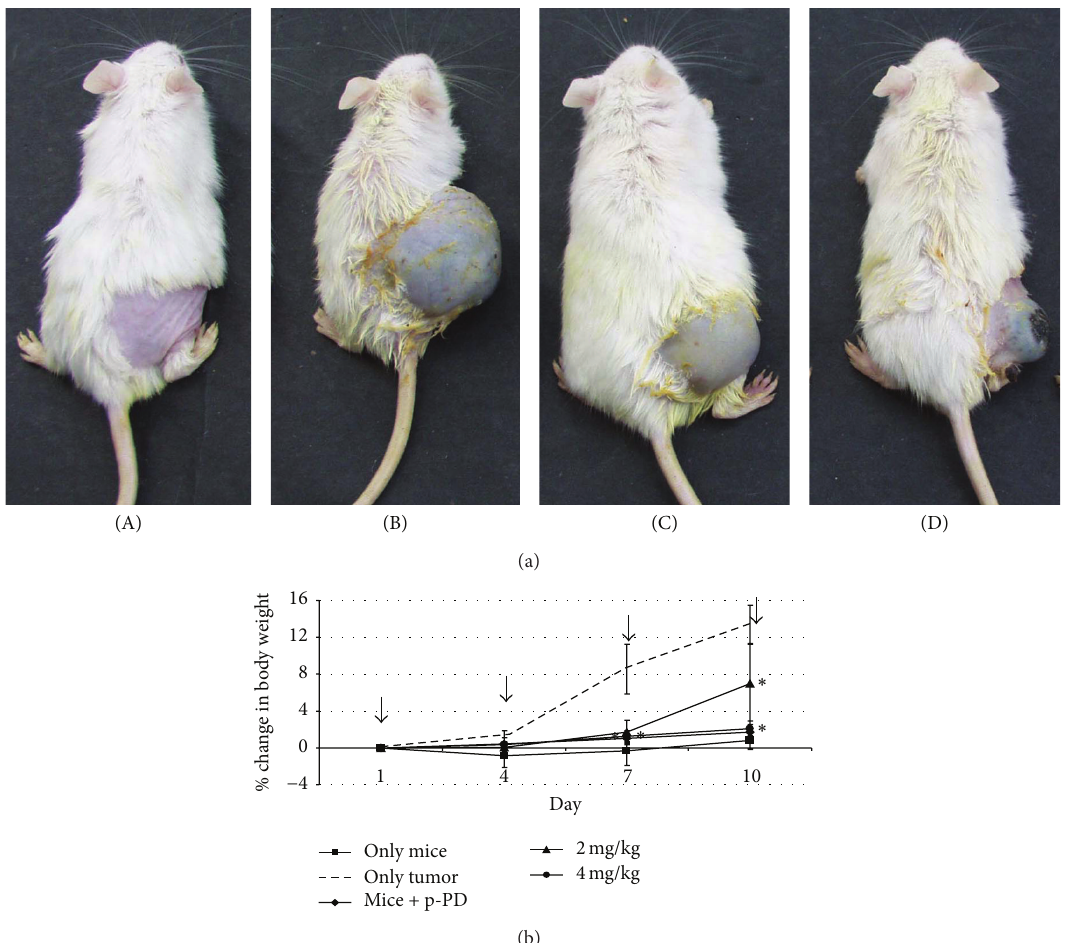
Figure 2: Body weight gain of the mice treated with or without p-PD. (a) Effect of p-PD on tumour development in mice. Initially, right flanks of two sets of Swiss-Albino mice were given subcutaneous injection with only PBS (A) and B16-F10 cells (B) as mentioned in the Materials and Methods. These mice were kept for 2 weeks until visible tumour in the set (B) is formed. The mice from set (B) were divided into three groups: one (C) was treated with 2 and the other (D) was treated with 4mg/kg of p-PD for 10 days. One (B) set was left untreated as control. Photographs of representative mouse from each set are shown here. Each set comprised 6 mice except for set (B) where initially 18 mice were used for the experiment. (b) Body weights of untreated mice (set (A) above) ( ◼ ), mice treated with 4 mg/kg of p-PD ( ⧫ ), mice having tumour (- - -) (set (B)), and mice having tumour treated with 2 ( 󳵳 ) (set (C)) and 4 ( ∙ ) mg/kg (set (D)) of p-PD are plotted against the days of treatment. Arrows indicate the time of peritoneal p-PD administration. Error bars represent SD; 𝑛 = 6 . ∗ indicates the two-tailed 𝑝 value ≤ 0.018. By conventional criteria, this difference is considered to be statistically